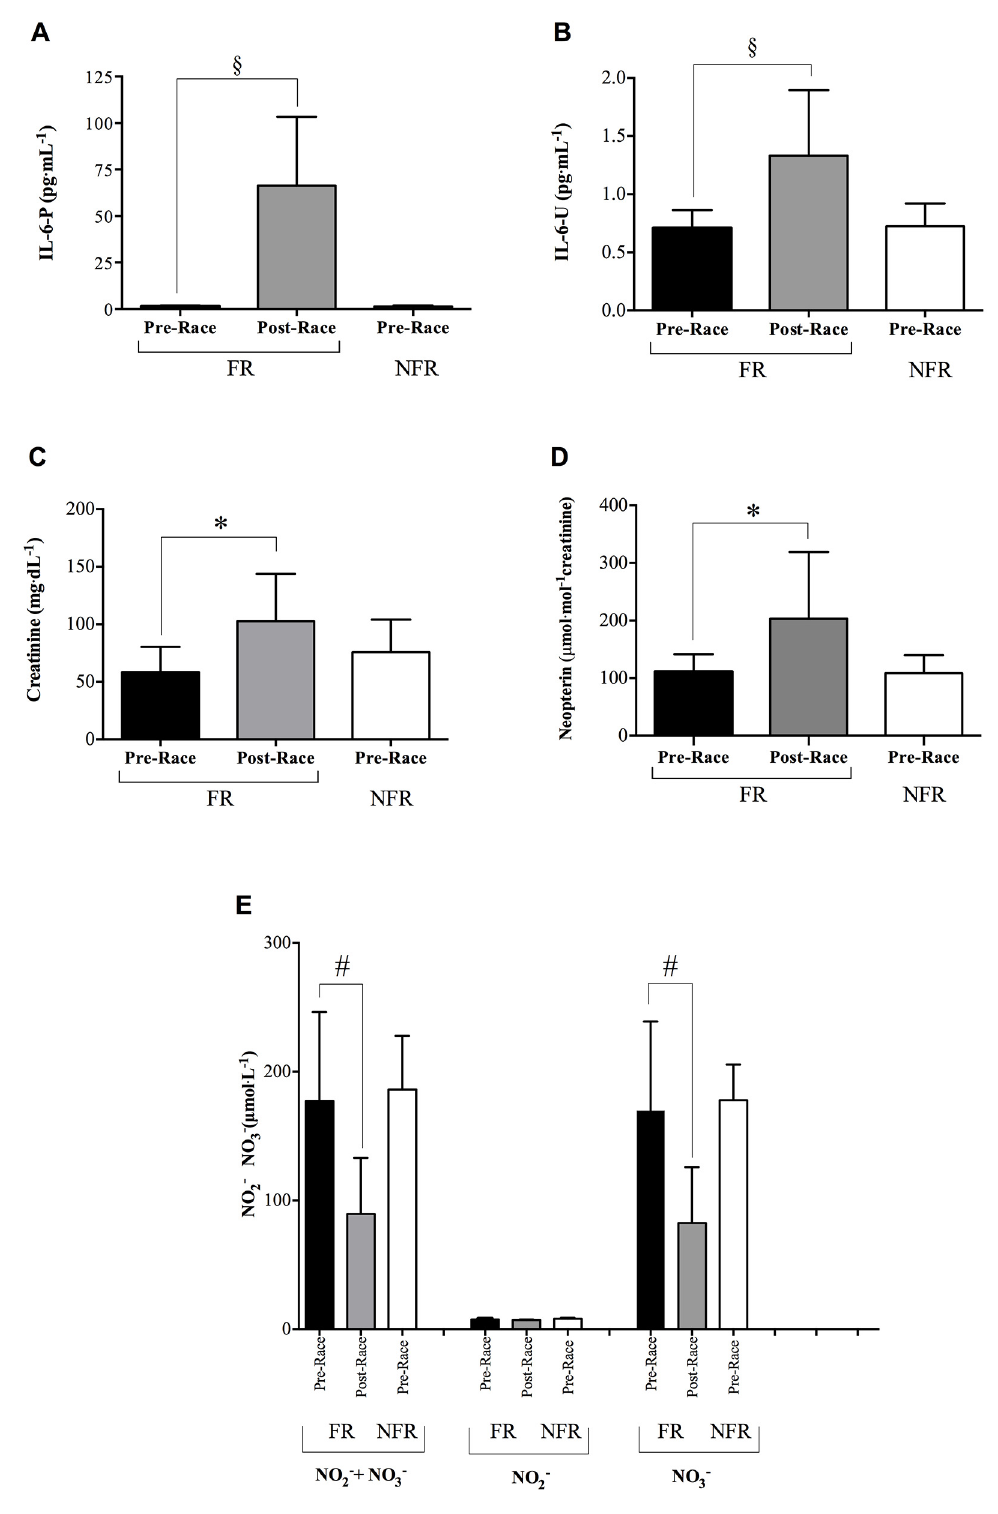
Fig 4. Effect of MUM on the inflammatory state. Histograms of: A) IL-6-P (pg . mL -1 ), B) IL-6-U (pg . mL -1 ), C) Creatinine (mg . dL -1 ), D) Neopterin ( μ mol . mol -1 creatinine) levels, and E) NO metabolites: Nitrite (NO 2- ) and Nitrate (NO 3 ) concentrations, in the FR (full bars) and NFR (empty bars) groups. Results are expressed as mean ± SD. Statistically significant differences symbols: P < 0.05 ( * ); P < 0.01 (#), P < 0.001 (§) compared to Pre-Race.